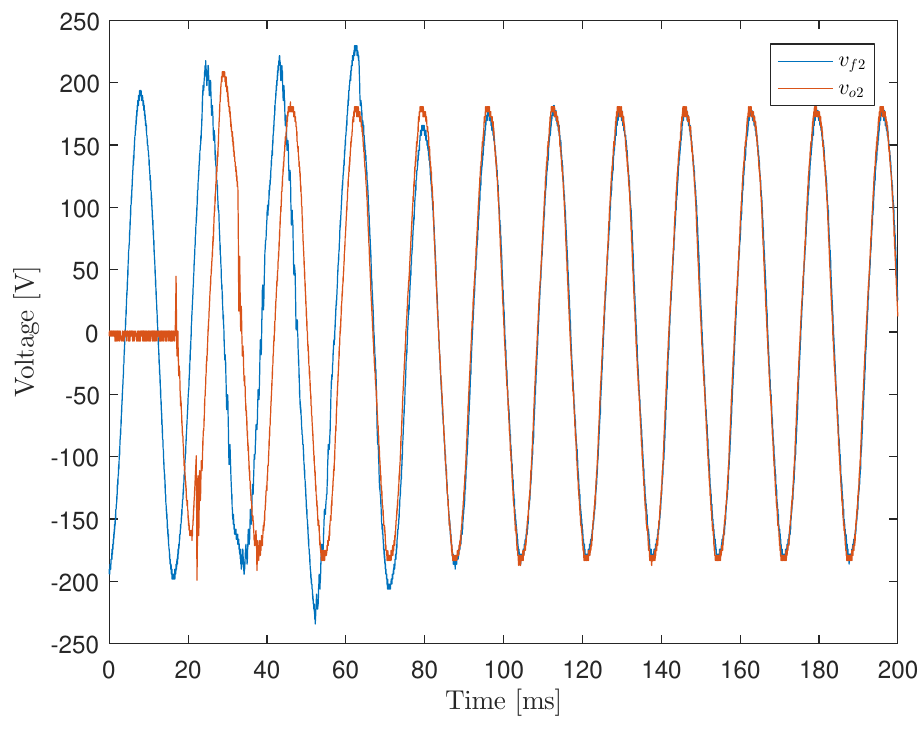
Figure 14. Pre-synchronization process for Inverter 2. Figure 15 shows the moment when the second inverter is connected to the microgrid. The measured voltages are v o 1 and v o 2 , as well as currents i o 1 and i o 2 (see Figure 12).